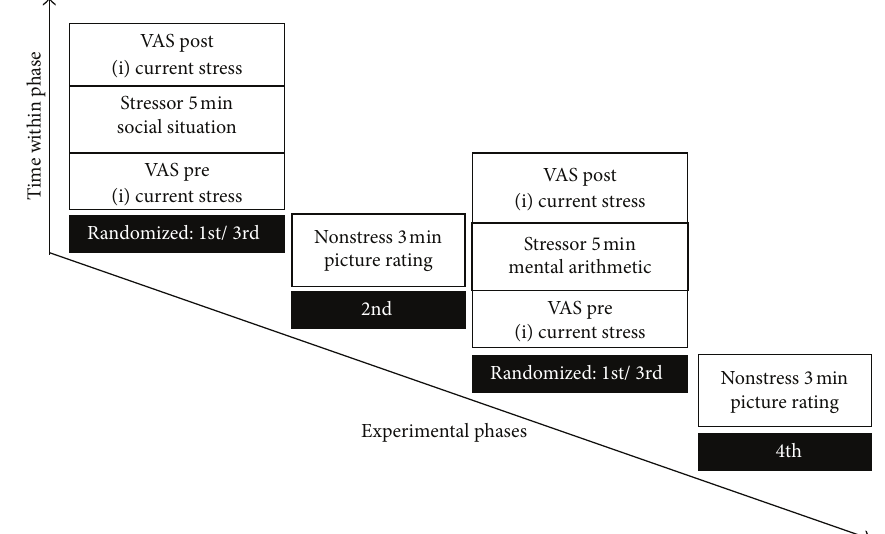
Figure 2: Procedure of the stress induction. VAS: Visual Analogue Scales. “1st/3rd”: randomized order of the phases.